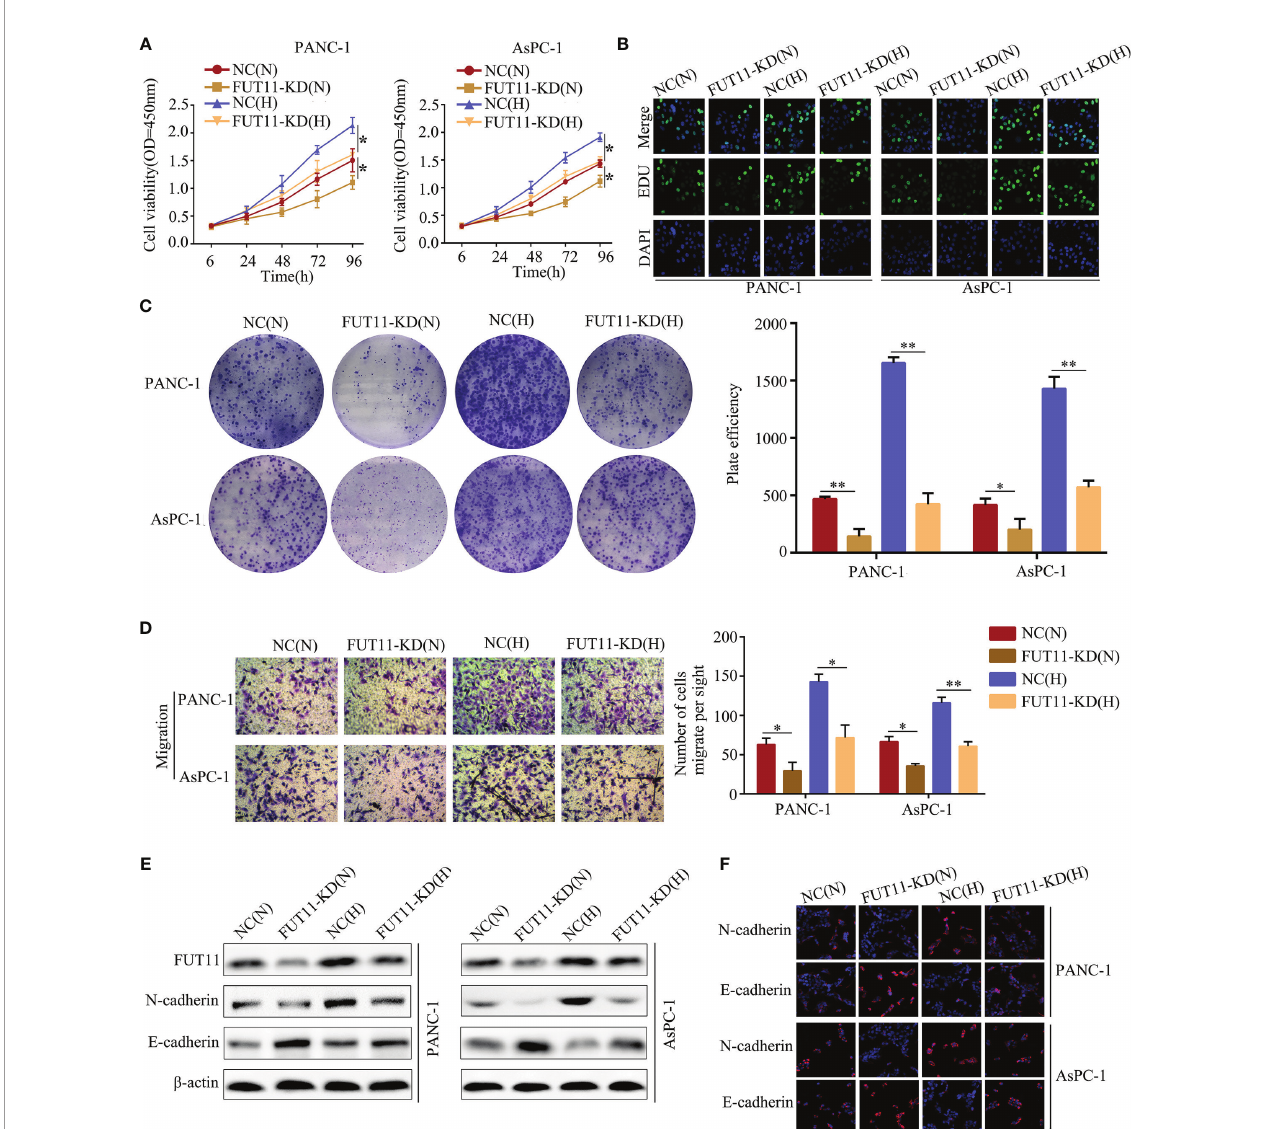
FIGURE 3 | FUT11 regulated the proliferation and migration of PC cells under normoxia and hypoxia in vitro . Targeted FUT11 lentivirus and negative control lentivirus were used to construct FUT11 knockdown cells and negative control cells, that were cultured either in normoxia or hypoxia. Cells were divided into four groups: NC(N), cells transfected with negative lentiviral and cultured in normoxia; FUT11-KD(N), cells with FUT11 knockdown and cultured in normoxia; NC(H), cells transfected with negative lentiviral and cultured in hypoxia; FUT11-KD(H), cells with FUT11 knockdown and cultured in hypoxia. (A) The effect of FUT11 on PC cell proliferation detected by CCK-8 assay. (B) The effect of FUT11 on PC cell proliferation detected by EDU assay. (C) The effect of FUT11 on PC cell colony forming ability detected by colony formation assay. (D) The effect of FUT11 on PC cell migratory ability detected by Transwell assays. (E) Western blotting used to detect the protein level of N-cadherin and E-cadherin of each group. (F) Immuno fl uorescent staining on the expression of N-cadherin and E-cadherin of each group. * P < 0.05; ** P <